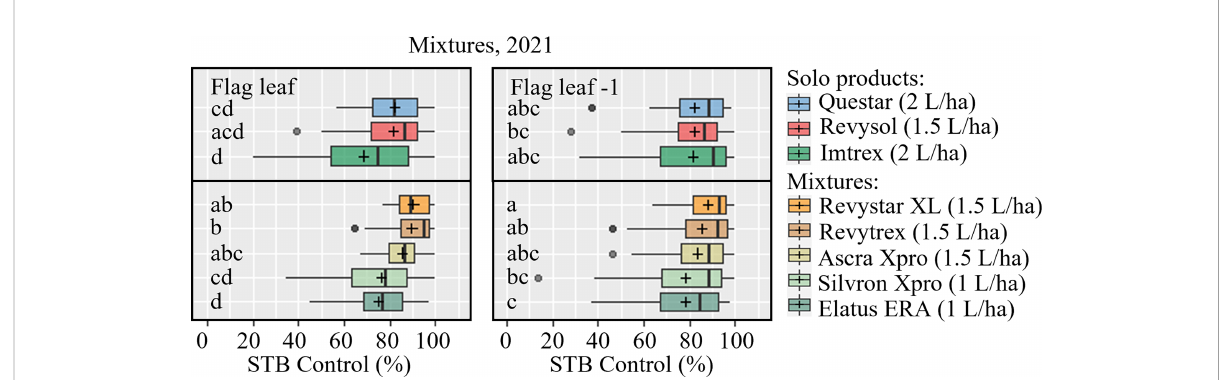
FIGURE 5 STB control (%) of mixtures on fl ag leaves (left) and F-1 leaves (right) were assessed at growth stage 65-83, 27-51 days after application in 9 trials in 2021. The trials were carried out in Denmark, the United Kingdom, Ireland, Belgium, France, Poland, and Germany. The tested fungicides included Questar (fenpicoxamid), Revysol (mefentri fl uconazole), Imtrex ( fl uxapyroxad), Revystar and Revytrex ( fl uxapyroxad + mefentri fl uconazole), Ascra Xpro (bixafen + fl uopyram + prothioconazole), Silvron Xpro (bixafen + fl uopyram), Elatus ERA (benzovindi fl upyr + prothioconazole). The line inside the boxes indicates the median and ‘ + ’ indicates the average. Different letters represent signi fi cant differences between treatments within boxplot as determined by Dunn ’ s test.